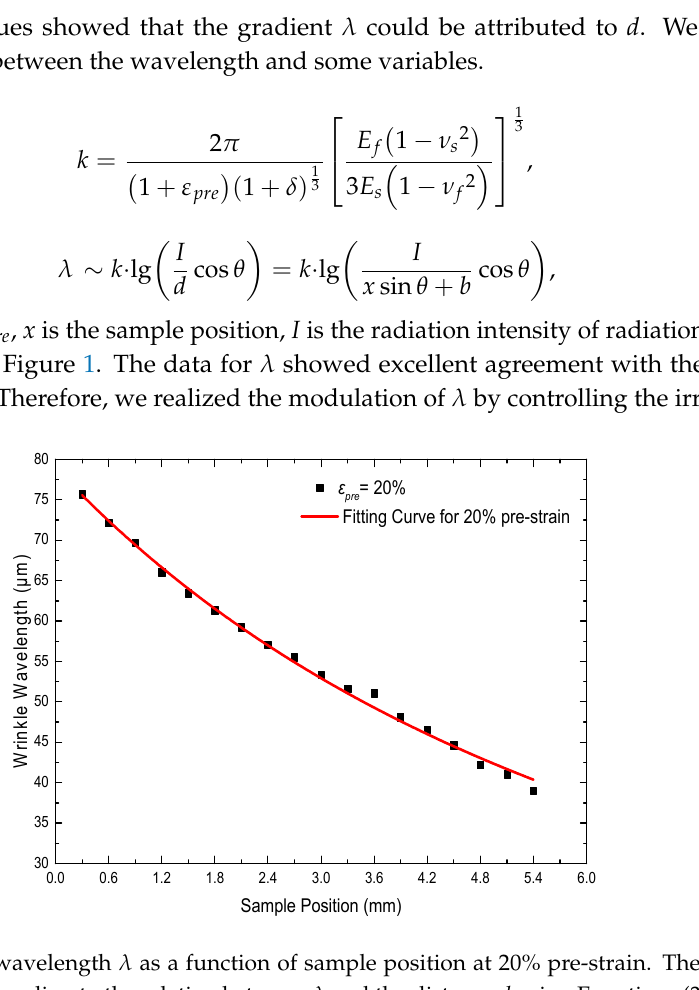
Figure 4. ( a ) Schematic diagram of the experimental device used to prepare ring wrinkles with a continuously changing wavelength. The PDMS membrane was fixed between two plates with round